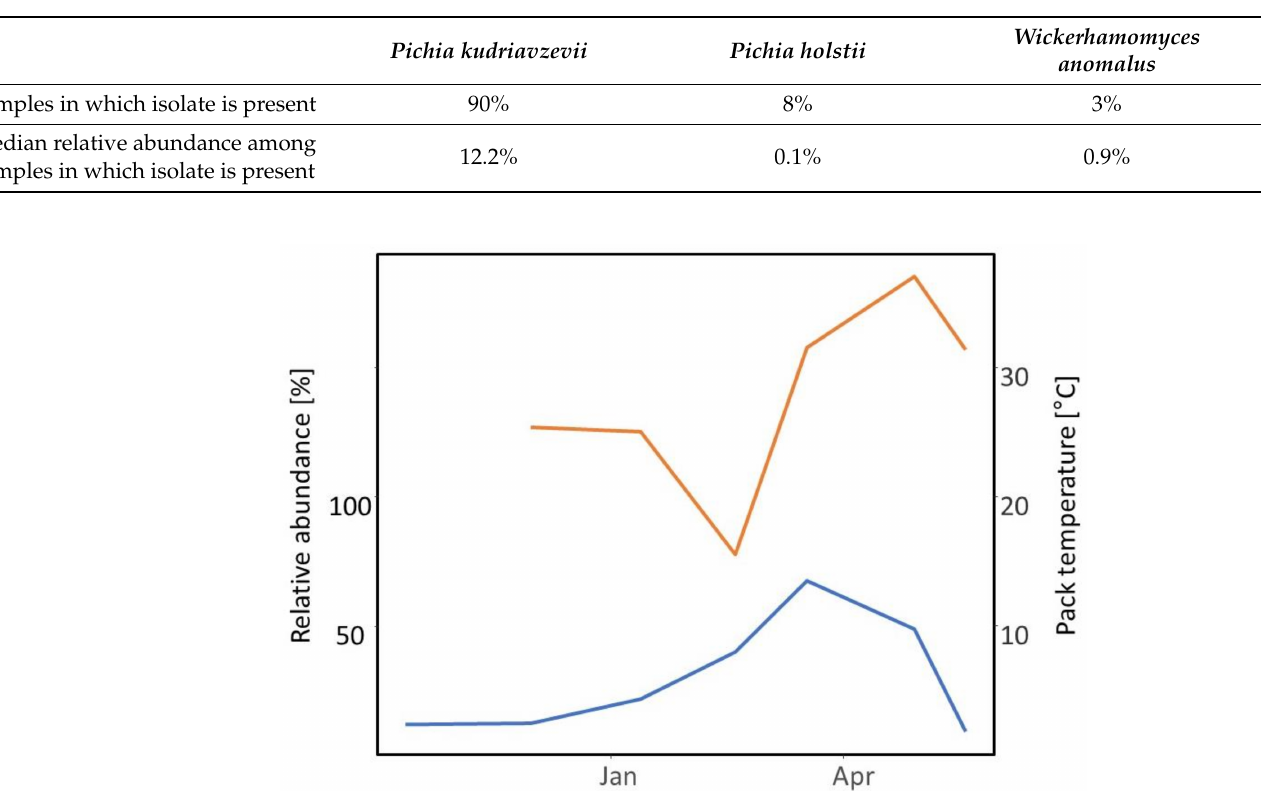
Table 4. Milk isolates cultured from milk also present in bedded pack samples from each of the five farms in phase 1 of the case study ( n = 40). Bedding samples were estimated by amplicon sequencing [15]. Sequence counts were converted to a proportion of total within-sample counts (relative abundance) and median relative abundance of OTUs with matching binomial epithets were calculated on a species basis among samples in which the matching taxa were present.